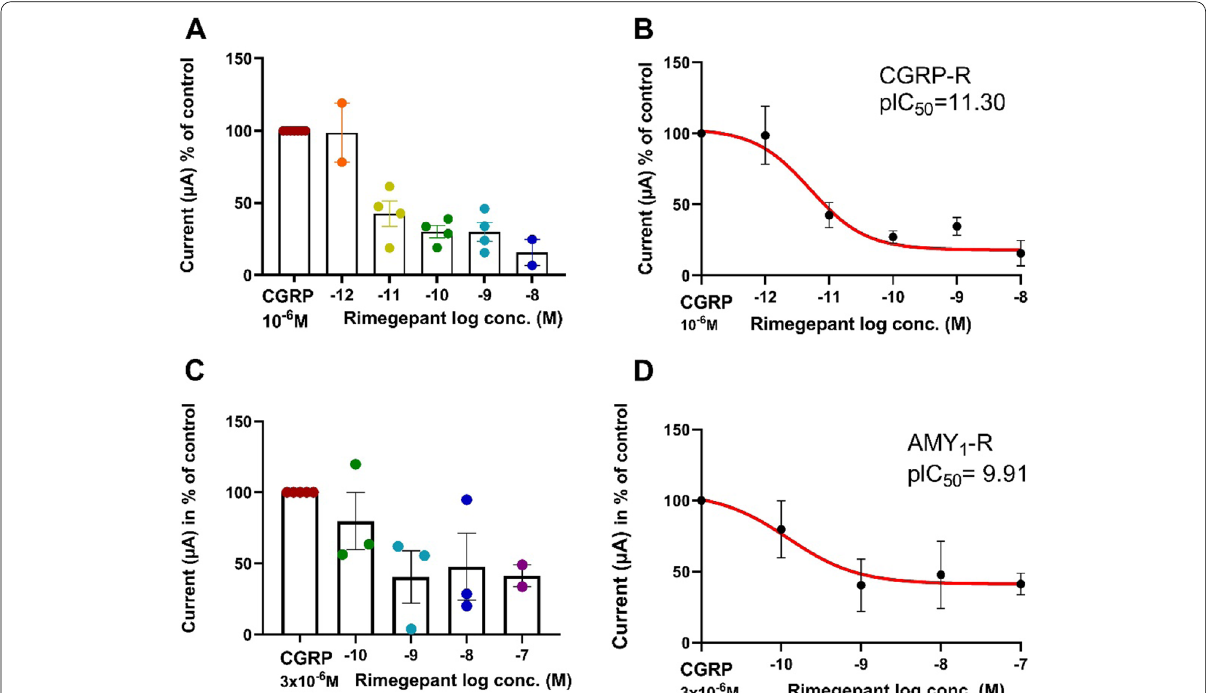
Fig. 6 The experiments show the rimegepant inhibition of CGRP induced currents in Xenopus Laevis oocytes expressing CGRP‑R ( A & B ) and AMY 1 ‑R ( C & D ). In A‑D , the current change to CGRP at each concentration of rimegepant is given in % of the current obtained for CGRP when given alone in 5‑7 batches of oocytes. At a given concentration of rimegepant in A & C each point represents the mean of 2‑4 identical experiments in one batch of oocytes. In B & D the least square non‑lin fit of the c‑r relationship of log[rimegepant] vs. response (three parameters) is shown for responses performed on CGRP‑R ( A ) and AMY 1 ‑R ( C ). The 23 data points shown in Fig. A are obtained from experiments performed on 61 oocytes from seven different batches. The same 23 data points are used for the curve fitting in B . The 16 data points shown in C are obtained from experiments performed on 36 oocytes from 5 different batches. The same 16 data points are used for the curve fitting in